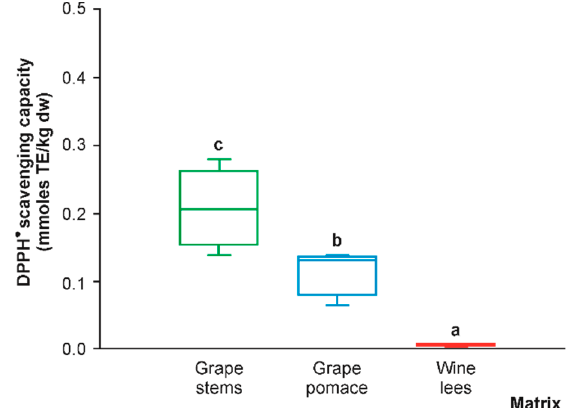
Figure 11. Box plots with quartiles (upper values 75%, median 50%, and lower values 25%) of DPPH • scavenging capacity (mmol TE/kg dw) of (poly)phenolic extracts of grape stems (green box), grape pomace (blue box), and wine lees (red box). Boxes with a different letter (a,b,c) within each plot indicate statistically significant differences according to the one-way analysis of variance (ANOVA) and Tukey’s multiple range test.